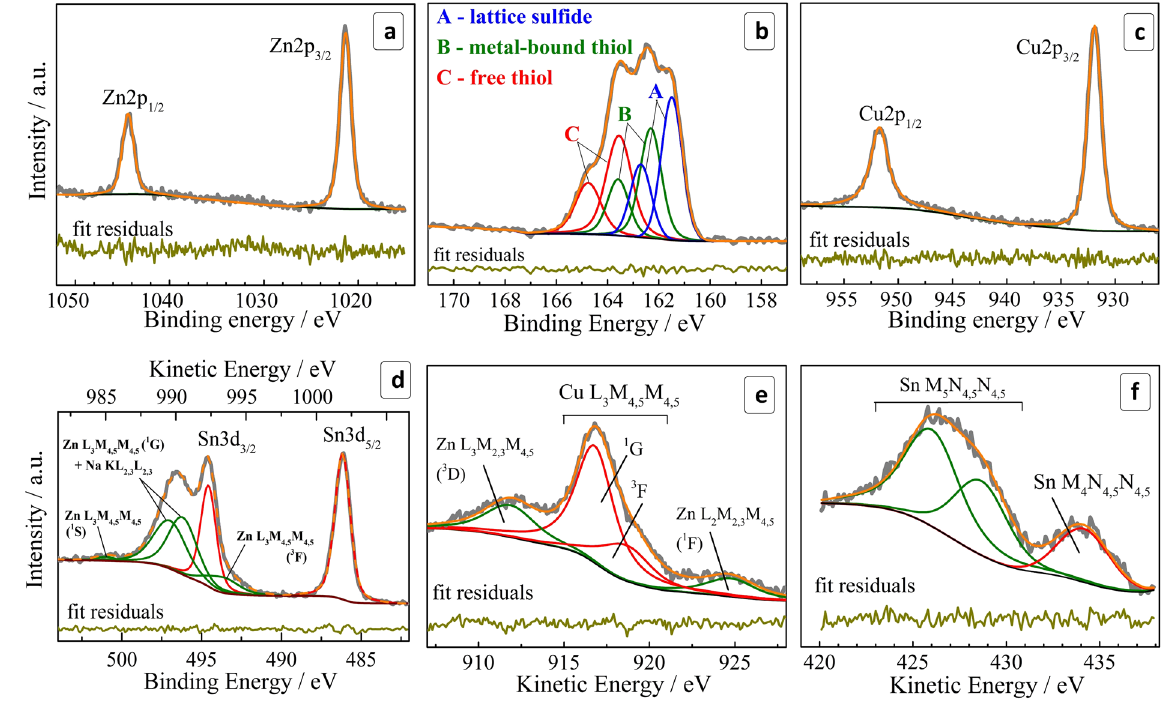
Figure 2. ( a – d ) High-resolution XPS spectra in the range of Zn 2p ( a ), S 2p ( b ), Cu 2p ( c ), and Sn 3d ( d ). ( e,f ) High-resolution spectra in the range of Auger electrons for copper ( e ) and tin ( f ). Attribution of Sn, Cu, Zn, and Na Auger peaks was performed according to refs 82–84